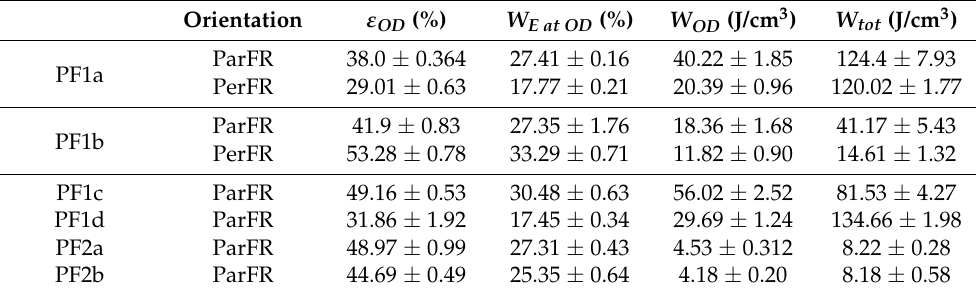
Table 4. Energy absorption properties.